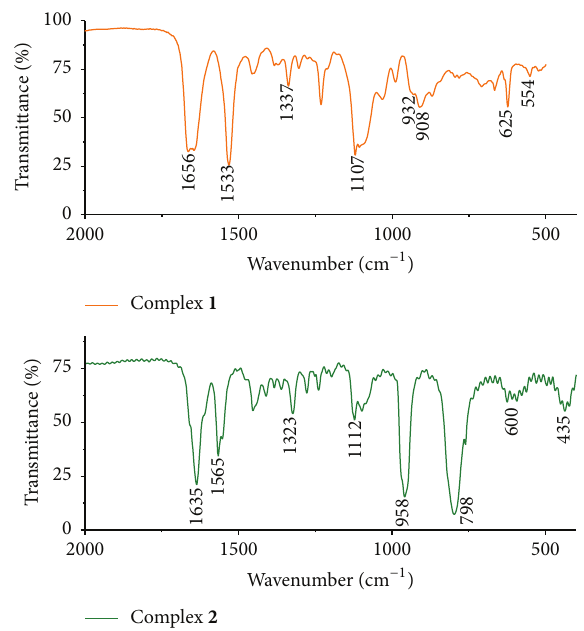
Figure 1: Infrared spectrum of complexes 1 and 2 in